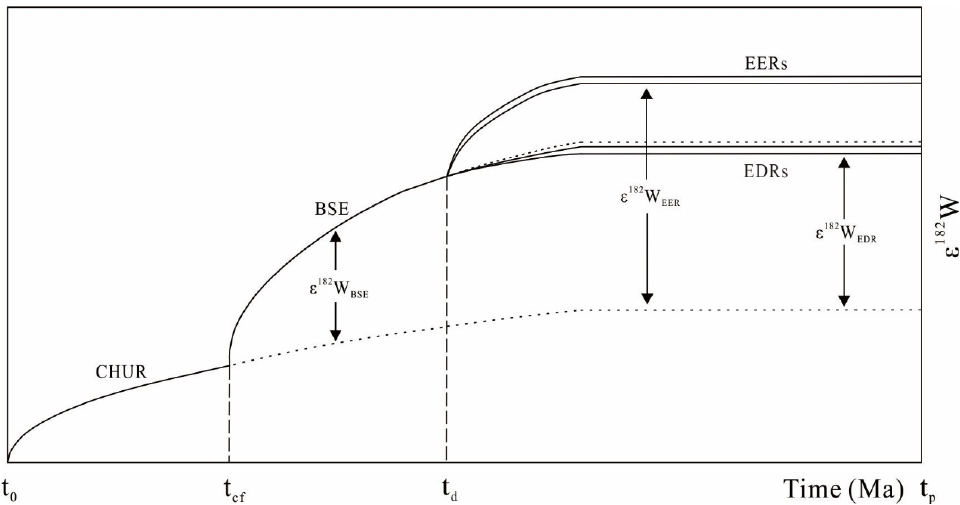
Figure 2. Three ‐ stage evolution of 182 W composition in the Earth. W isotope data are generally reported with ε 182 W values, expressed as ε 182 W = [( 182 W/ 184 W) sample /( 182 W/ 184 W) BSE − 1] × 10 4 , which means per 10,000 deviations of 182 W/ 184 W from the value of the BSE.